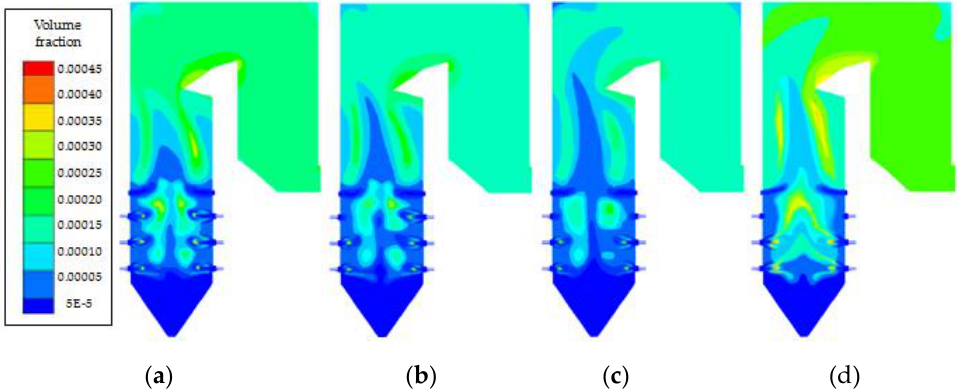
Figure 7. NOx concentration distribution under different loads: ( a ) NOx concentration distribution under 600 MW boiler load; ( b ) NOx concentration distribution under 500 MW boiler load; ( c ) NOx concentration distribution under 400 MW boiler load; ( d ) NOx concentration distribution under 250 MW boiler load.